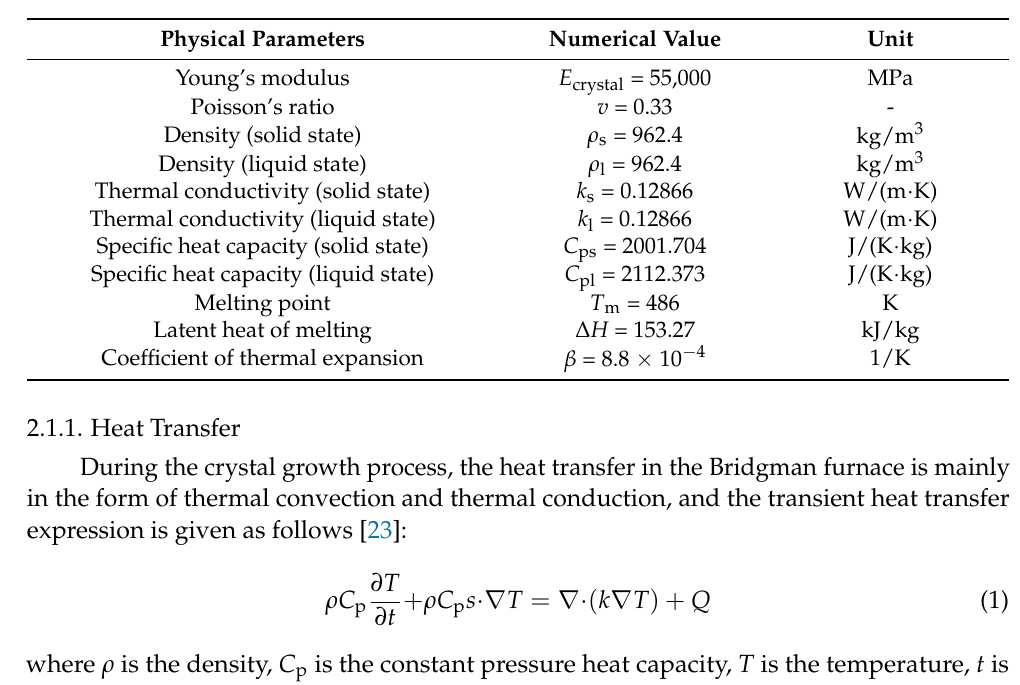
Table 1. Physical parameters